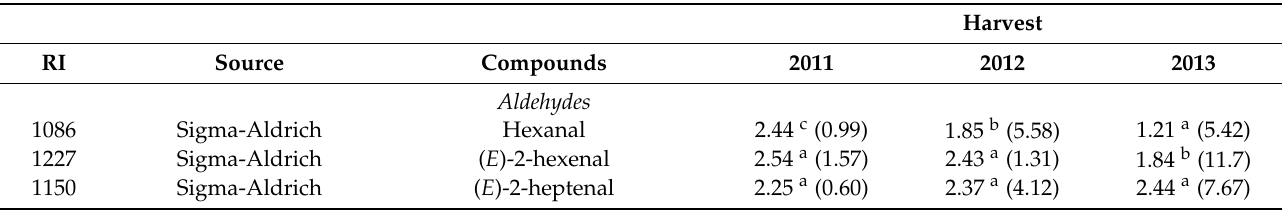
Table 2. Volatile compounds of La Mancha Trujillo melons. Mean concentration ( µ g/L) and relative standard deviations ( n =